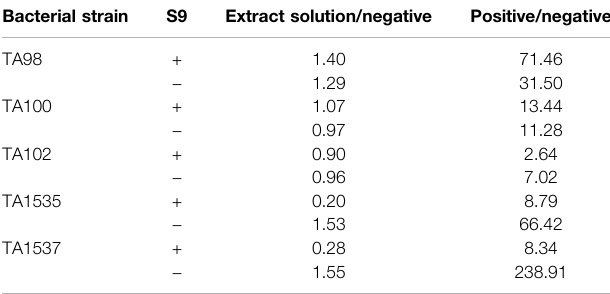
TABLE 2 | The ratios of the revertant colony numbers of the tested groups a . Bacterial strain